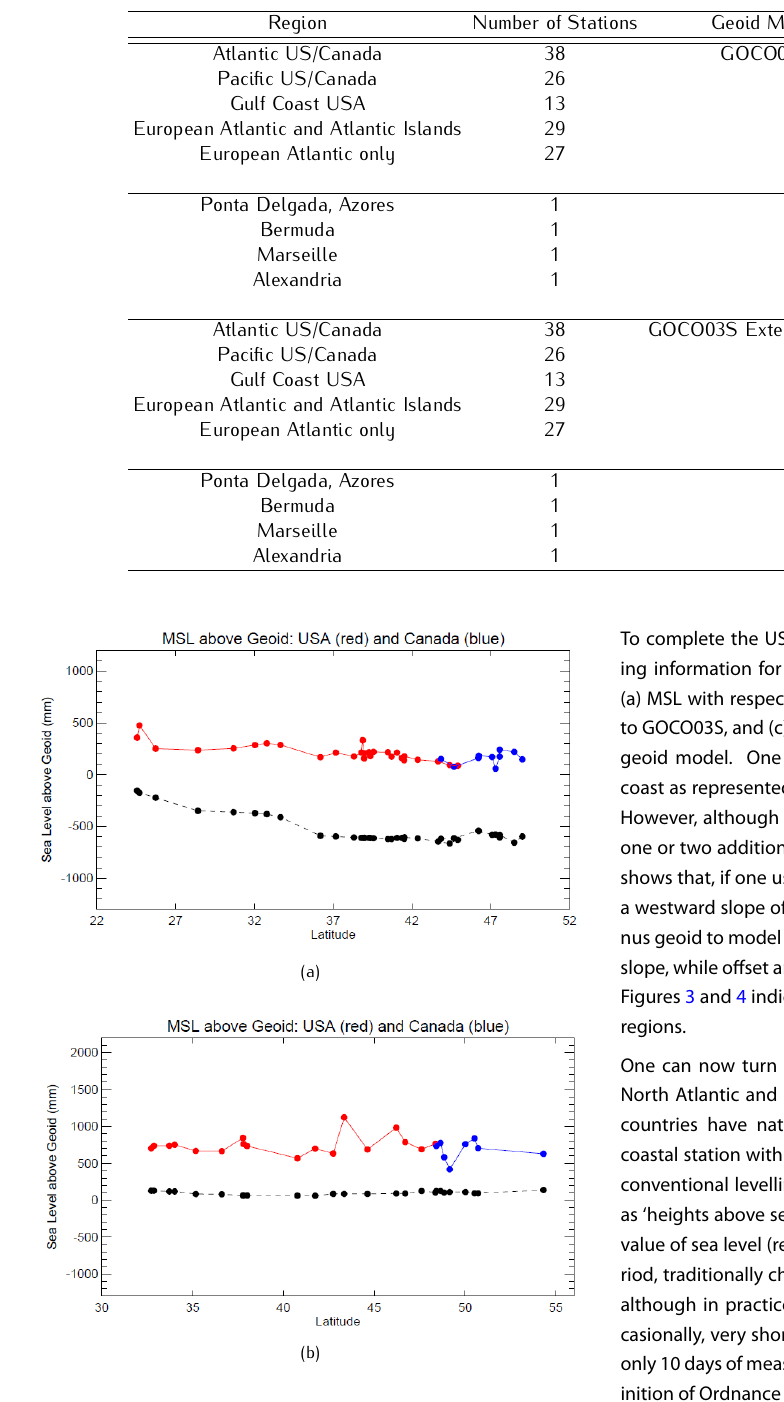
Figure 4. Equivalent information to Figure 3(a,b) but using the Ex- tended GOCO03S geoid